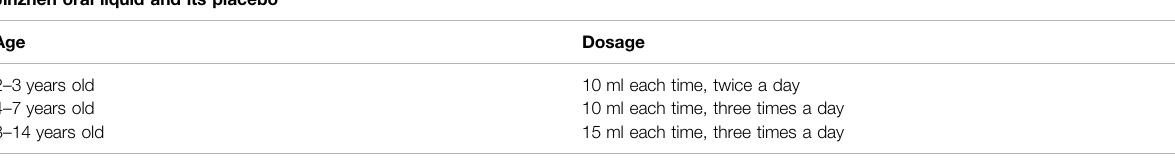
TABLE 1 | Usage instructions for both drugs. Jinzhen oral liquid and its placebo